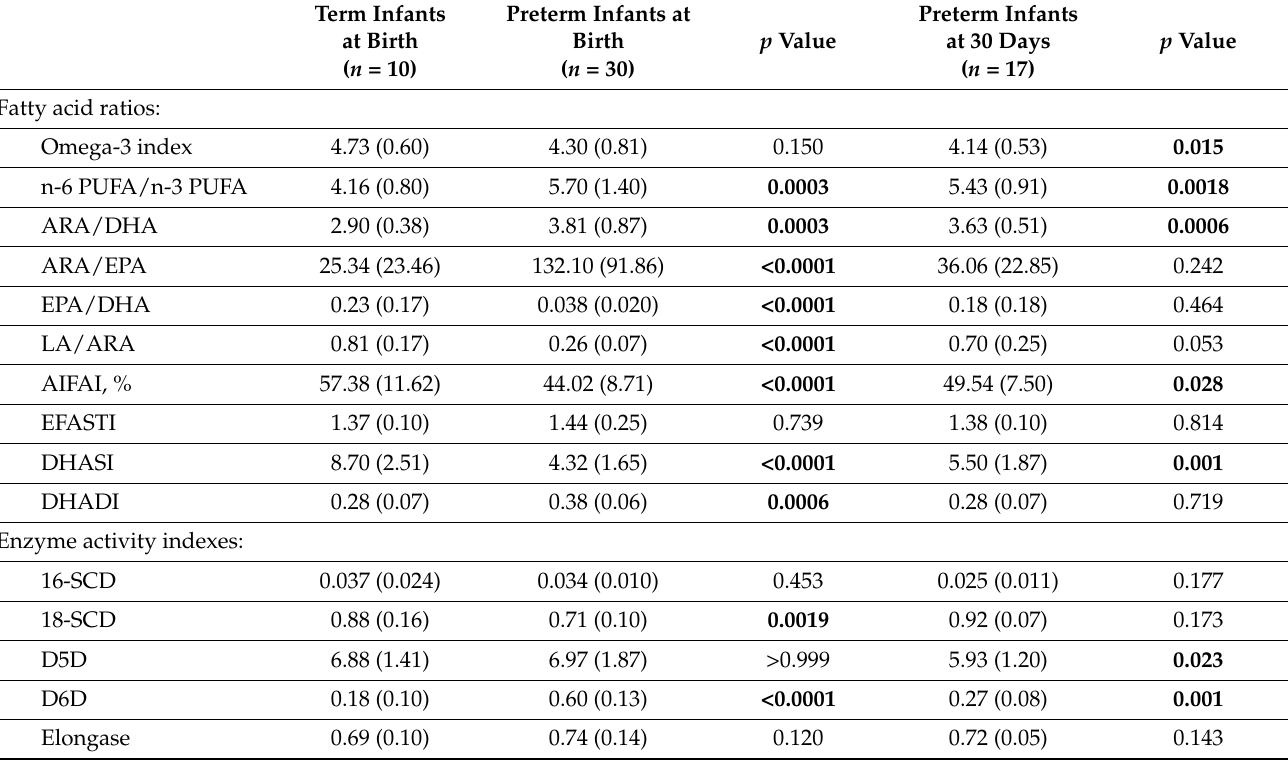
Table 4. Estimated fatty acid ratios and enzyme activity